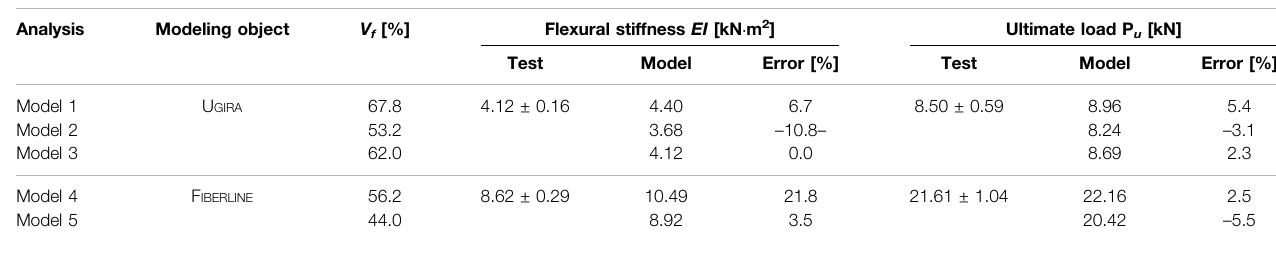
TABLE 4 | Accuracy analysis of numerical